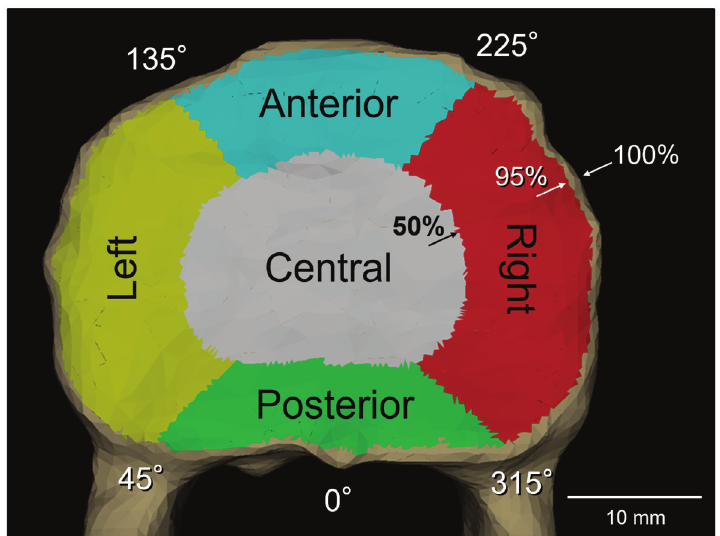
Fig 4. Definition of the five topographic zones, superimposed on a vertebra surface model. Note that osteophytes mesh elements with over 45˚ tilt angle and the most outer margin of the endplate where the cortical wall of the vertebral body exists underneath the endplate are not included in the peripheral zones.